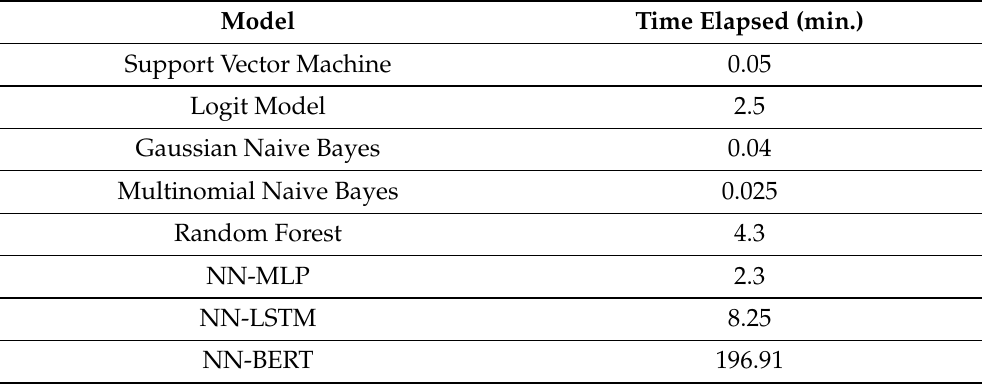
Table 6. Training times per